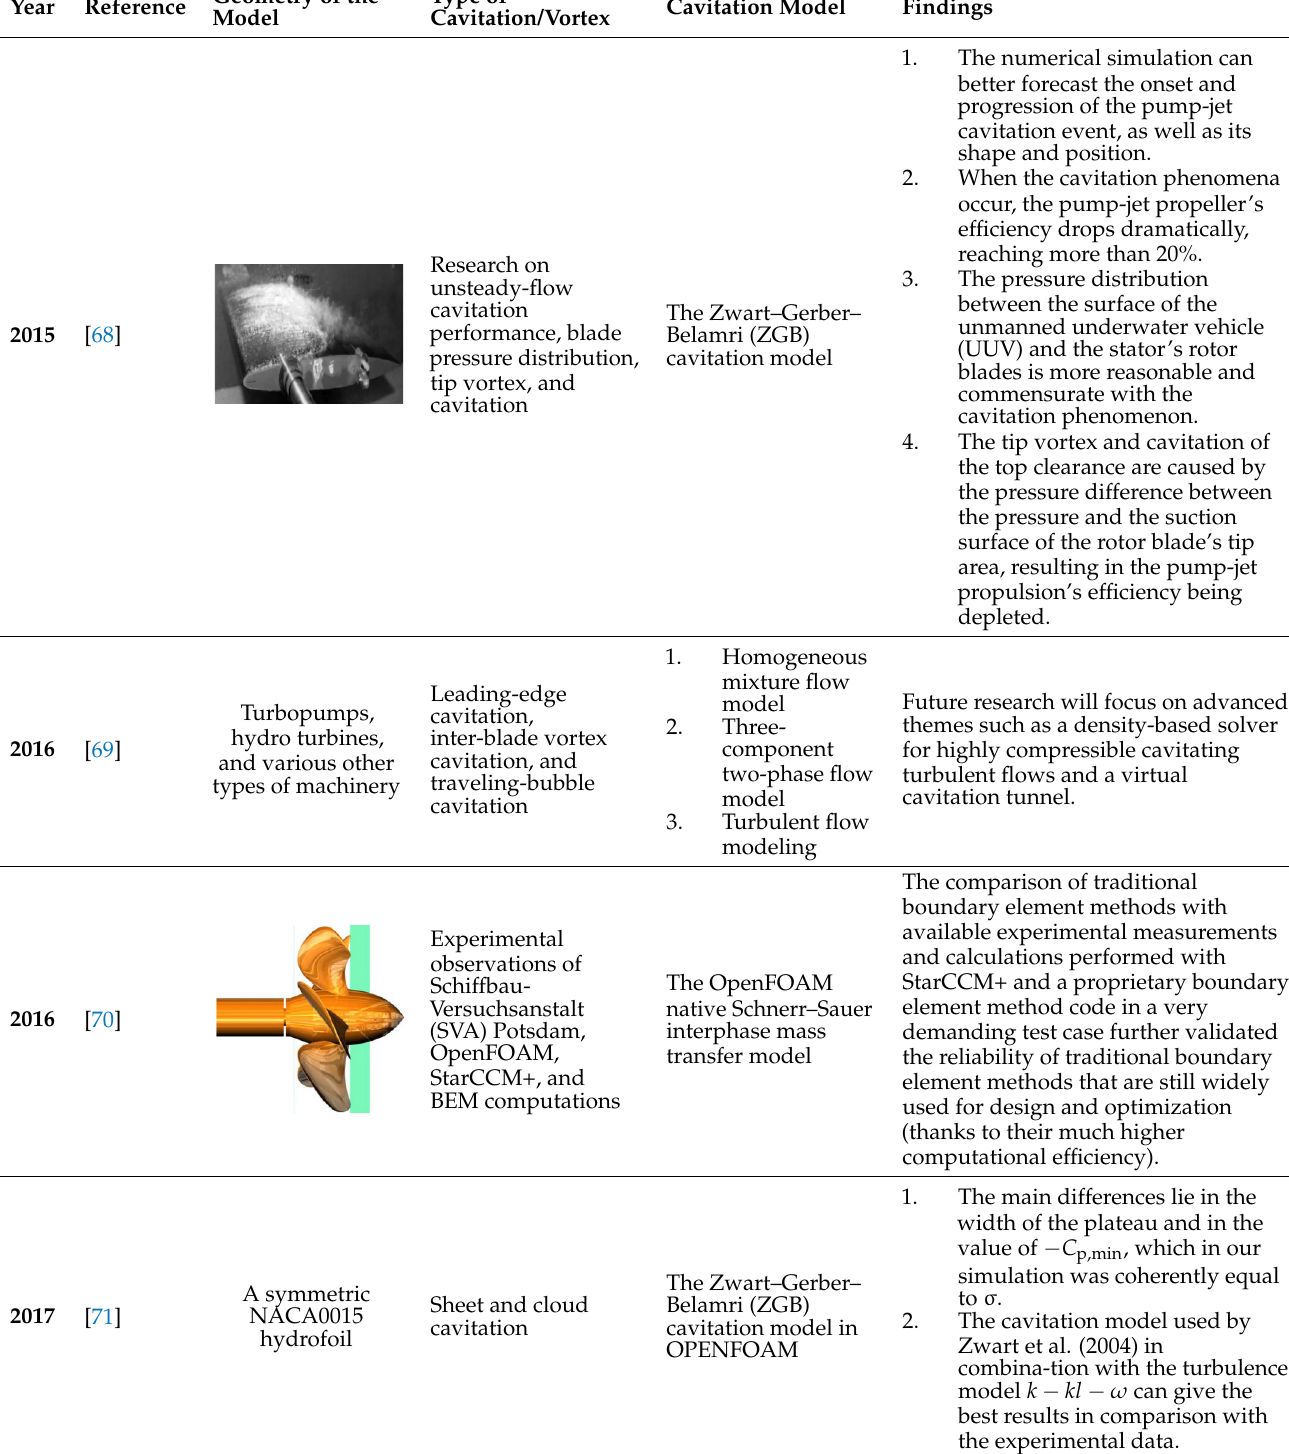
Table 5. Summary of the effect of the gap-flow model on the hydrodynamic performance of IMP